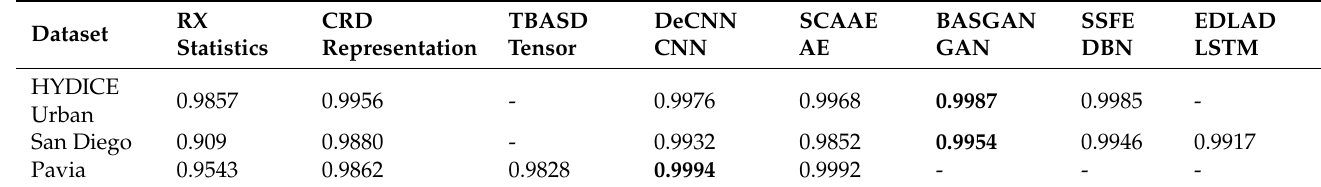
Table 3. AUC performance comparison between hybrid model and other